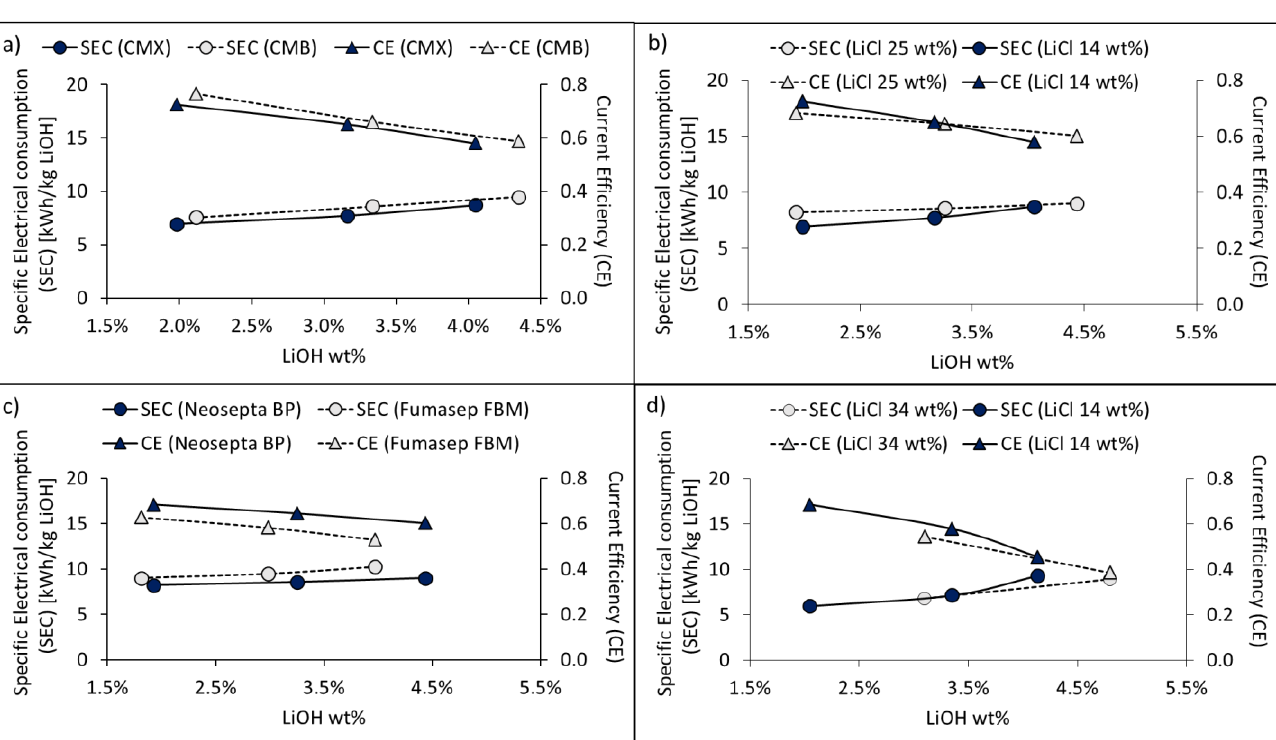
Figure 11. Specific electricity consumption and current efficiency under different operating conditions: ( a ) comparison of the cationic membranes CMX and CMB (Test 1 and Test 2); ( b ) comparison of 14 and 25 wt% LiCl concentrations at 1000 A∙m − 2 (Test 1 and Test 3); ( c ) comparison of the bipolar membranes Neosepta BP and Fumasep FBM (Test 3 and Test 4); ( d ) comparison of 14 and 34 wt% LiCl concentrations at 500 A∙m − 2 (Test 5 and Test 6) Initial LiOH concentration 0.5 wt%.